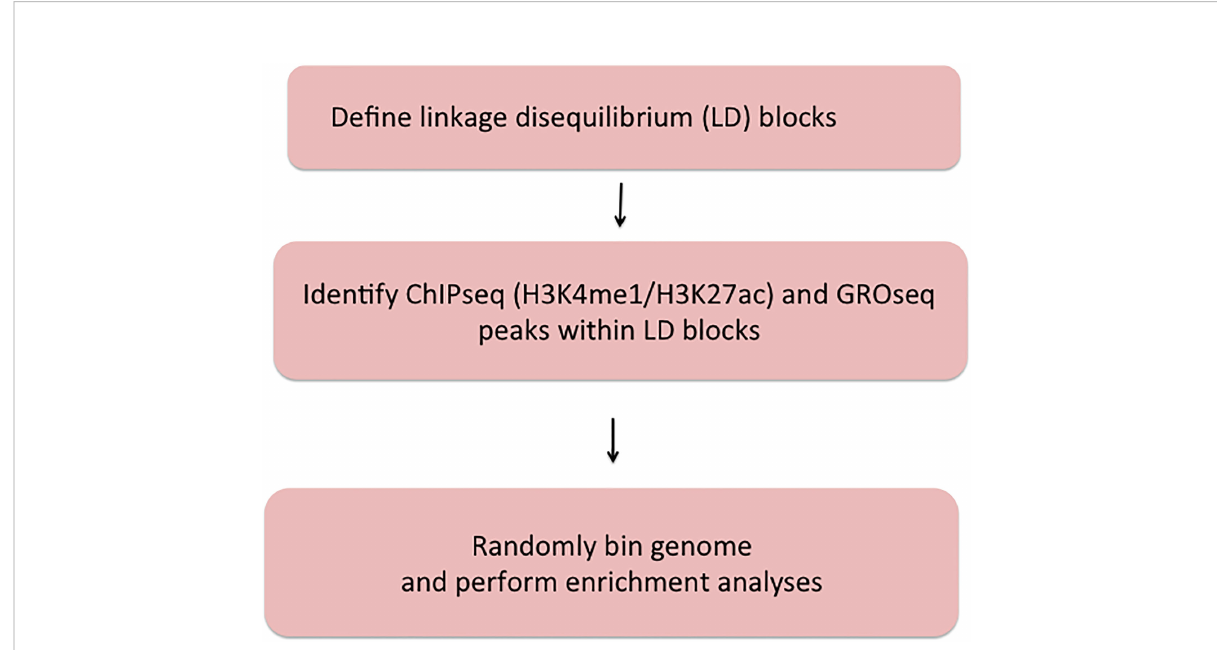
FIGURE 1 Summary of methods used to query JIA risk regions using the Single Nucleotide Polymorphism Annotator (SNiPA) and publicly available genomic